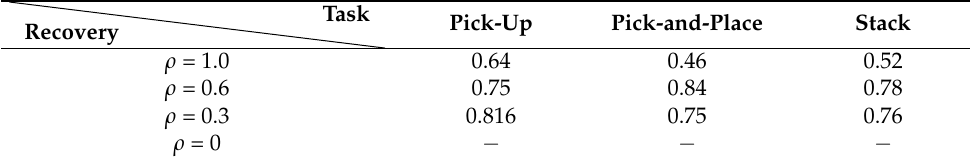
Table 3. Performance comparison depending on the state recovery probability ρ . Task Pick-Up Pick-and-Place Stack Recovery ρ =